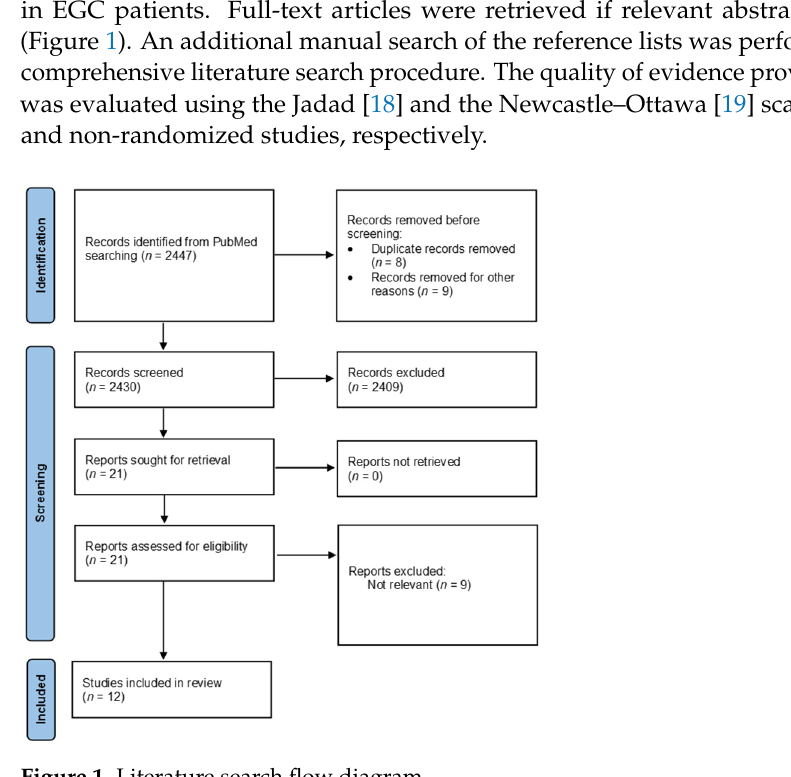
Figure 1. Literature search flow diagram.